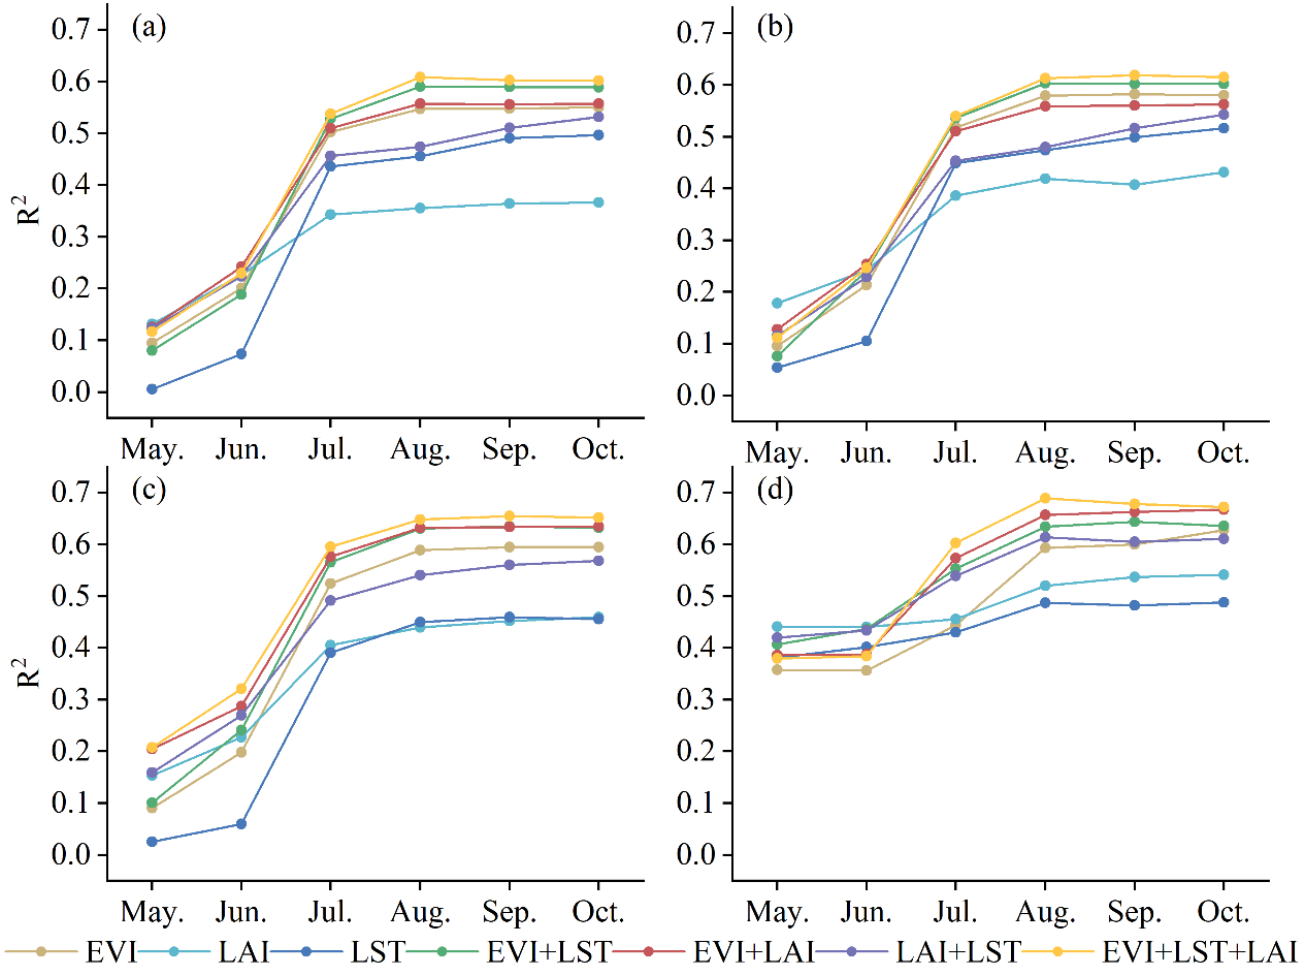
Figure 7. Changes in model performance during the GS for the four methods (( a )–LASSO, ( b )–SVR, ( c )–RF and ( d )–LSTM). Each sub-figure shows the change in model performance with time. The performance of models improved with time as more data became available with each passing month.